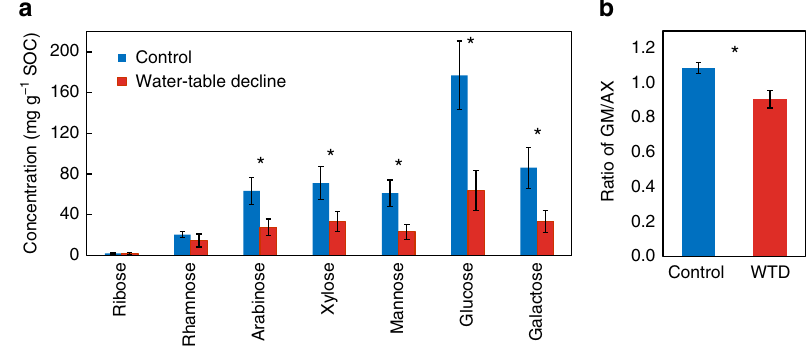
Figure 3 | Concentrations and ratios of neutral sugars in the submerged soil. ( a ) Soil organic carbon (SOC)-normalized concentration of neutral sugars and ( b ) the ratio of (galactose þ mannose)/(arabinose þ xylose) (GM/AX) in the subsoils (30–40cm; o 53 m m) under the control and water-table decline (WTD) treatments. Error bars represent s.e.m. ( n ¼ 4). Asterisk denotes significant difference between treatments ( P o